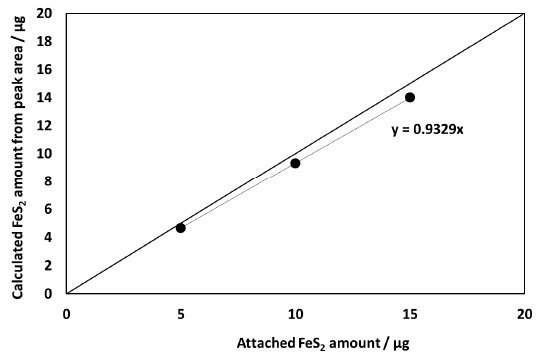
Figure 4. Relationships between the attached amount of pyrite on the platinum plate surface and the calculated amount of pyrite from the peak area of Gaussian fitted peak with the voltammogram.